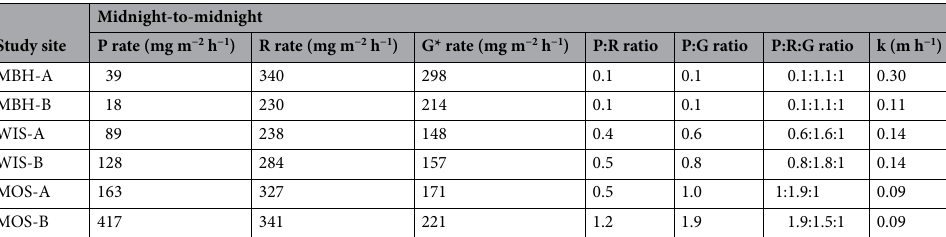
Table 4. Overview of modelled midnight-to-midnight photosynthesis (P), ecosystem respiration (R) and gross gas exchange (G*) rates and ratios, and gas exchange (G) coefficients (k) at the streams Mähringsbach (MBH), Wiesent (WIS) and Moosach (MOS) with respective upstream (A) and downstream (B) sites.